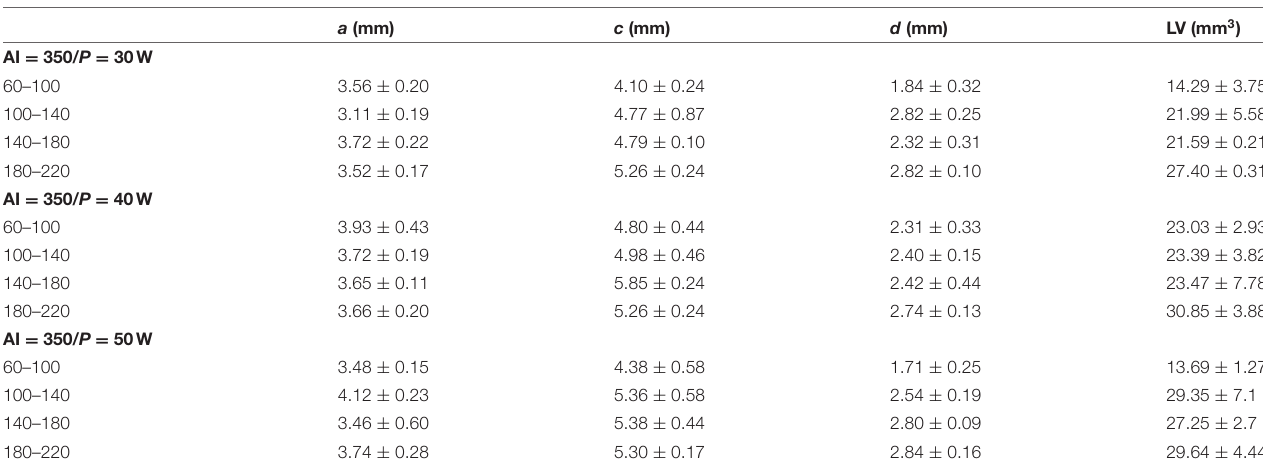
TABLE 1 | Lesion information of every group (AI = 350), which is represented by the means ± SDs. a